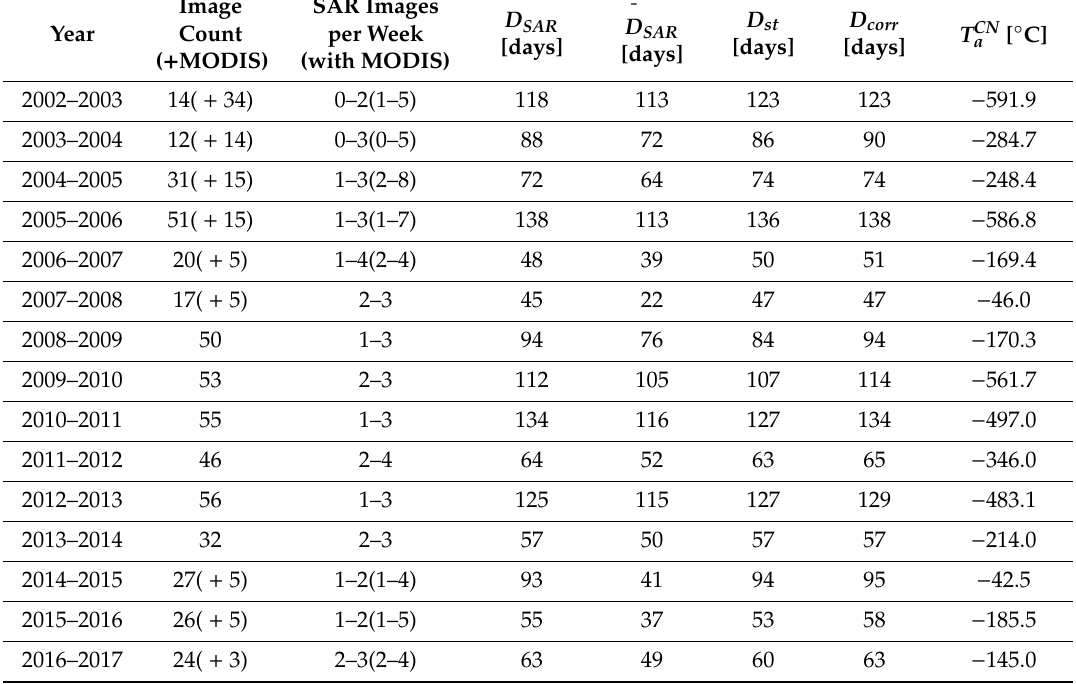
Table 2. Summary of the processed satellite data and ice season duration (ISD). D SAR is a maximum value of the ISD, D SAR —spatial-mean ISD, D st —maximum value of the ISD observed at the coastal stations, and D corr is a corrected ISD, T CN a is a cumulative negative air